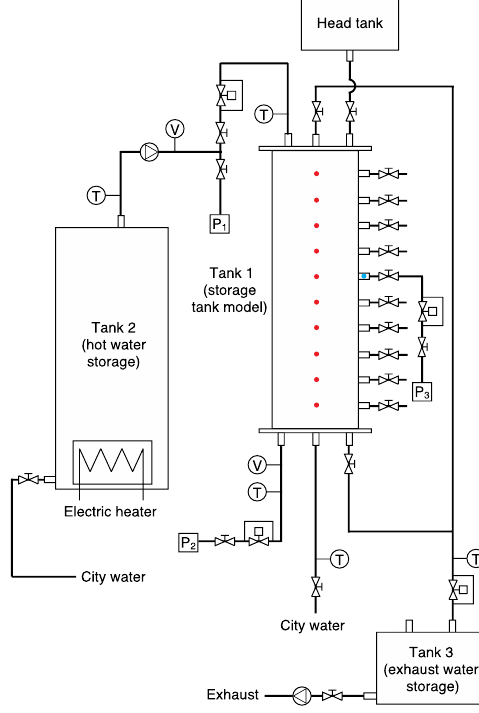
Figure 3. Experimental setup. Table 1. Specification of storage tank model for experimental setup.